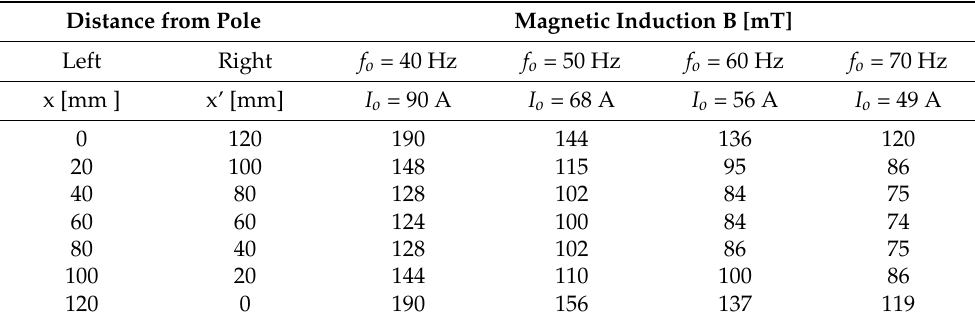
Figure 6. Distribution of the measured value of the magnetic induction inside the working chamber: ( a ) along a line between opposite poles; ( b ) along lines parallel to the side edge of the working chamber (each series represents different measuring point on the working chamber cross-section). Table 1. Measured values of magnetic induction B for different output frequencies f o and measured output current I o